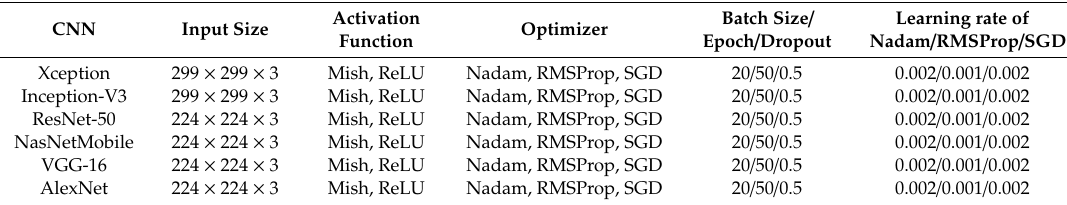
Table 2. The experimental setting of the CNN models for the training and validation